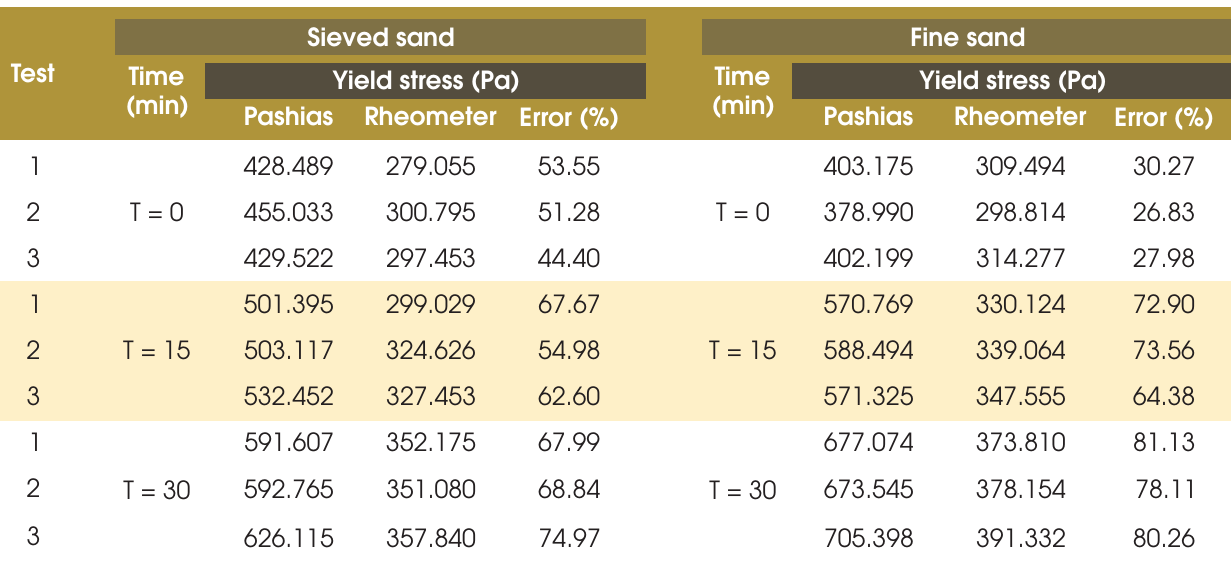
Table 10 – Comparison of yield stress calculated by the method of Pashias and by classical rheometry with their respective errors for mortars with w/c ratio =